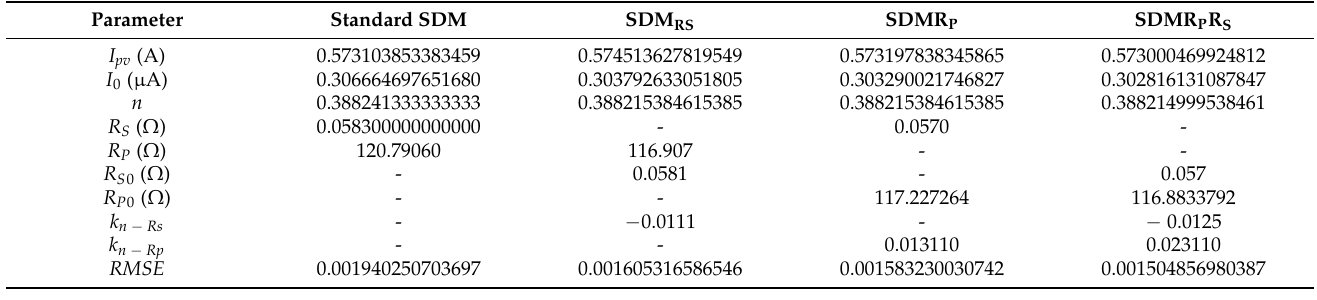
Figure 12. Experimental setup of the solar laboratory module . Table 5. Estimated parameters value for proposed equivalent circuits for the observed solar laboratory module.